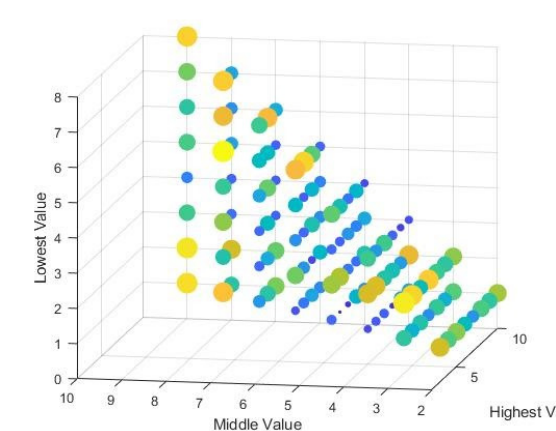
Figure 5: RMS value of variance dataset (50x)